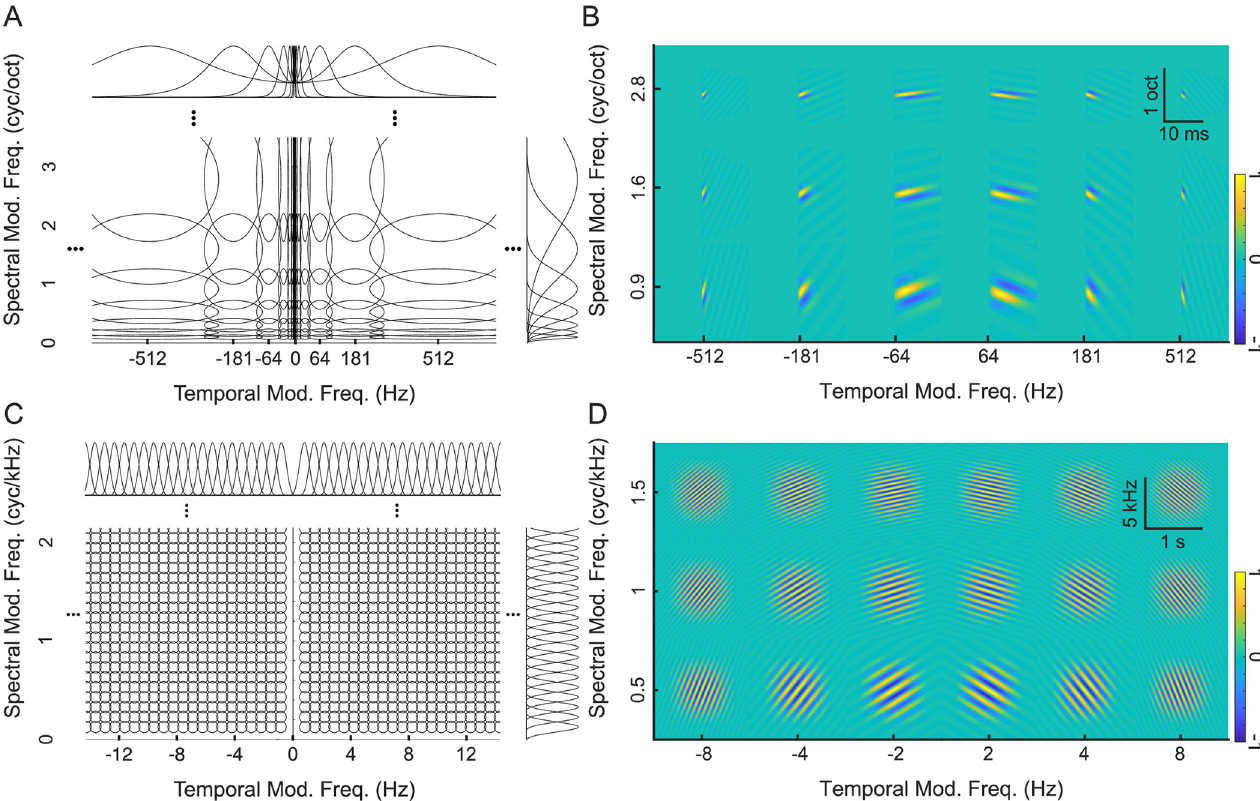
Fig 6. Fourier and midbrain modulation filterbanks. Modulation decomposition filters are shown for (A) the midbrain filterbank and (C) the Fourier-based filterbank, with each transfer function contoured at the 3dB level (50% power). Note that the Fourier-based modulation filters have equal resolution in both spectral and temporal dimensions, whereas the midbrain modulation filters have proportional resolution as observed physiologically (i.e., bandwidth scaling). The corresponding STRFs are shown for both the (B) midbrain filterbank and (D) Fourier-based filterbank. Note that the Fourier-based STRFs have equal duration and bandwidth whereas the durations and bandwidths scale for midbrain